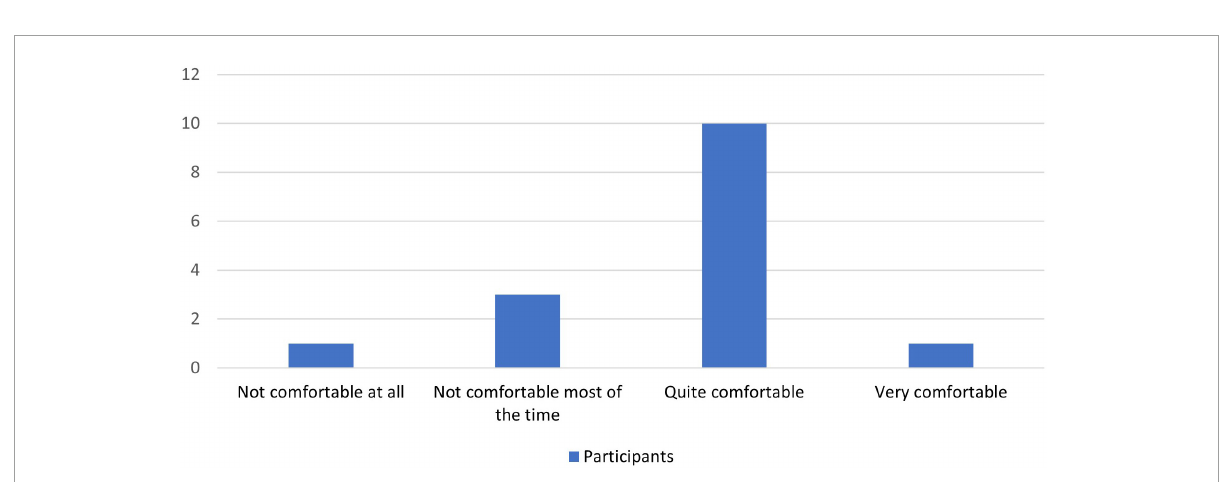
FIGURE7 Feedback on the comfort level of using the Augmented Reality Games to Enhance Vocational Ability of Patients (REAP) augmented reality equipment.